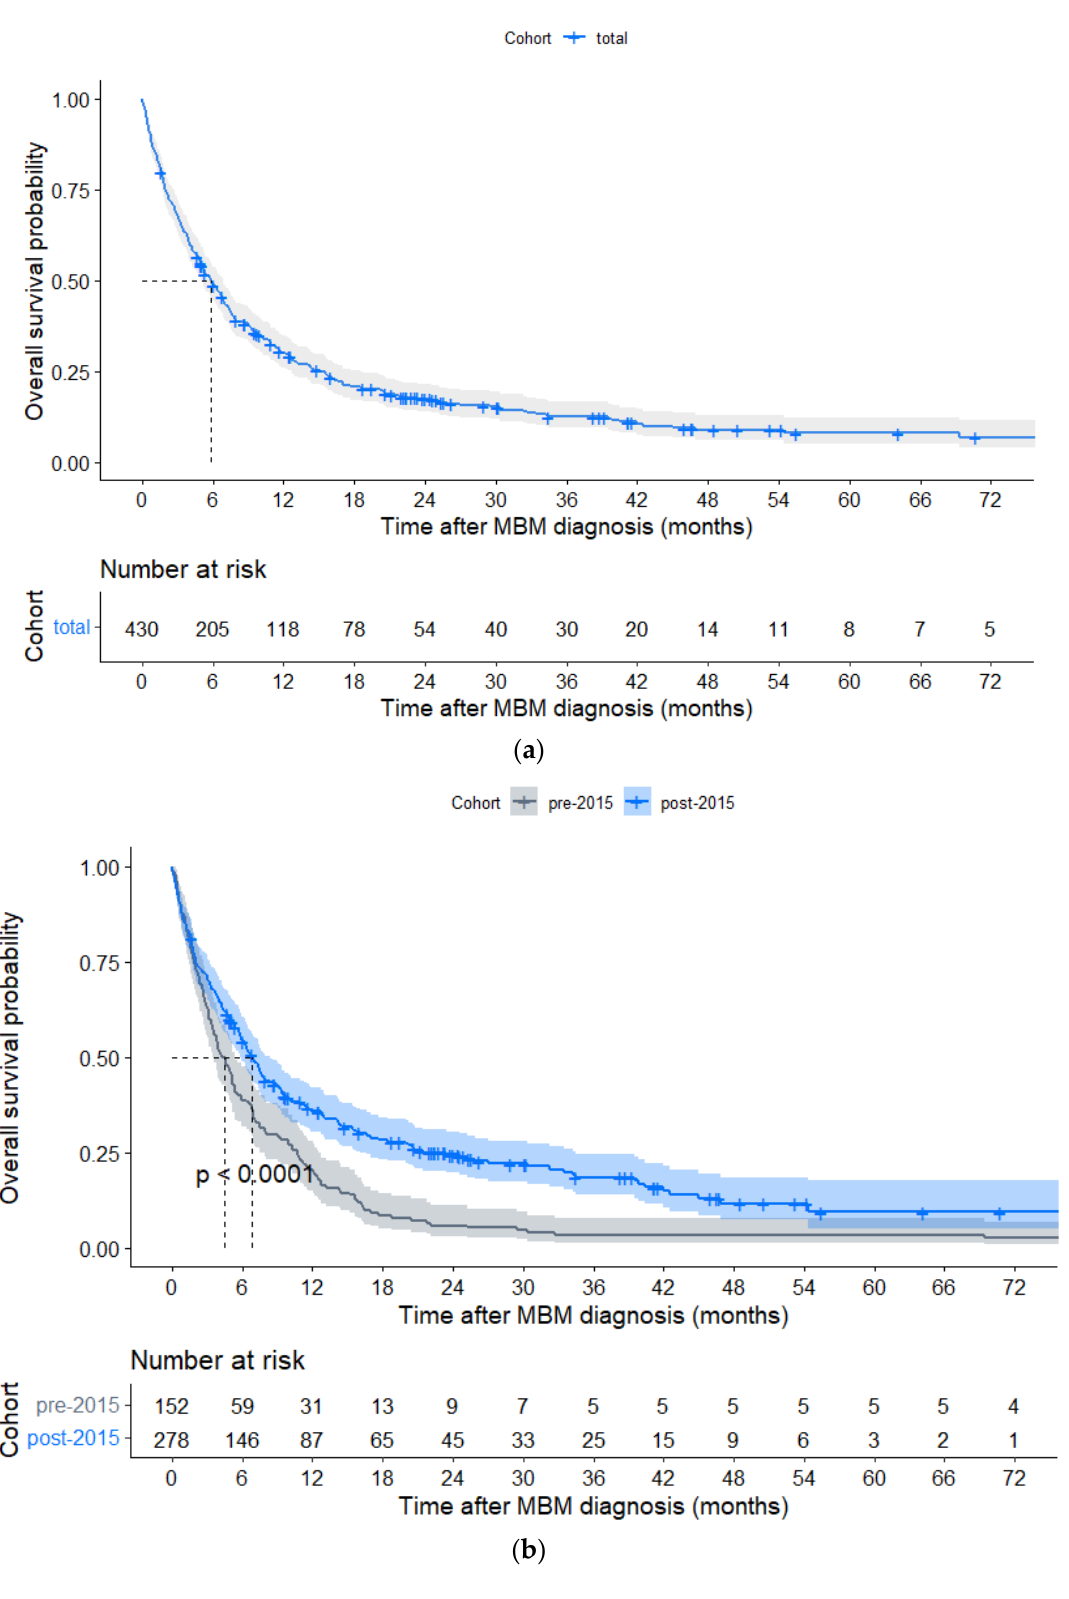
Figure 1. ( a ) Kaplan–Meier curve of overall survival in the total cohort ( n = 430) of patients with melanoma brain metastasis (MBM). ( b ) Kaplan–Meier curves of overall survival of patients diagnosed with MBM pre-2015 ( n = 152) and post-2015 ( n =